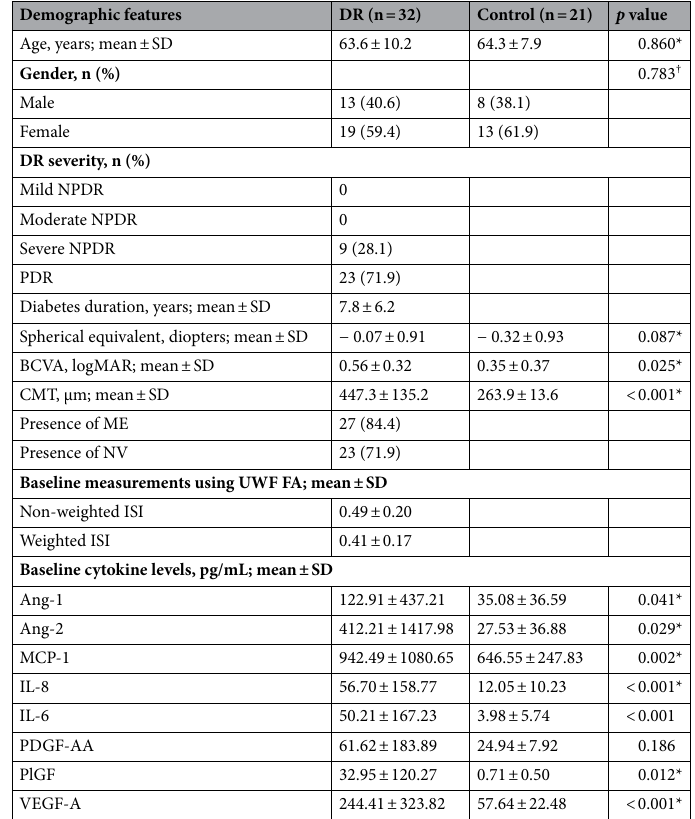
Table 1. Patient characteristics, demographics, clinical features, and cytokine levels. BCVA best-corrected visual acuity, DR diabetic retinopathy, CMT central macular thickness, ISI ischemic index, logMAR logarithm of the minimum angle of resolution, ME macular edema, NPDR non-proliferative diabetic retinopathy, NV neovascularization, PDR proliferative diabetic retinopathy, SD standard deviation, *Mann–Whitney U test. † Chi-square